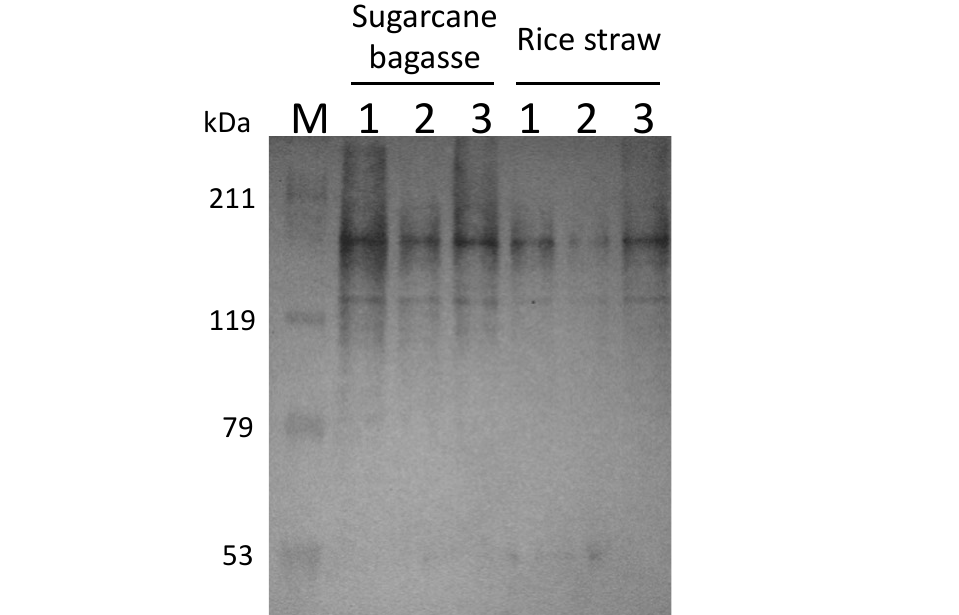
Figure 4. Western blot analysis of the supernatant and adsorption or non-adsorption fractions to crystalline cellulose from sugar bagasse and rice straw media. Lane M: Protein mass marker; lane 1: supernatant fraction; lane 2: non-adsorption fraction with Avicel; lane 3: adsorption fraction with Avicel. The anti-CbpA antibody was used as 1:2000 dilution. By using the cellulosome fractions from cellobiose, sugarcane bagasse and rice straw,